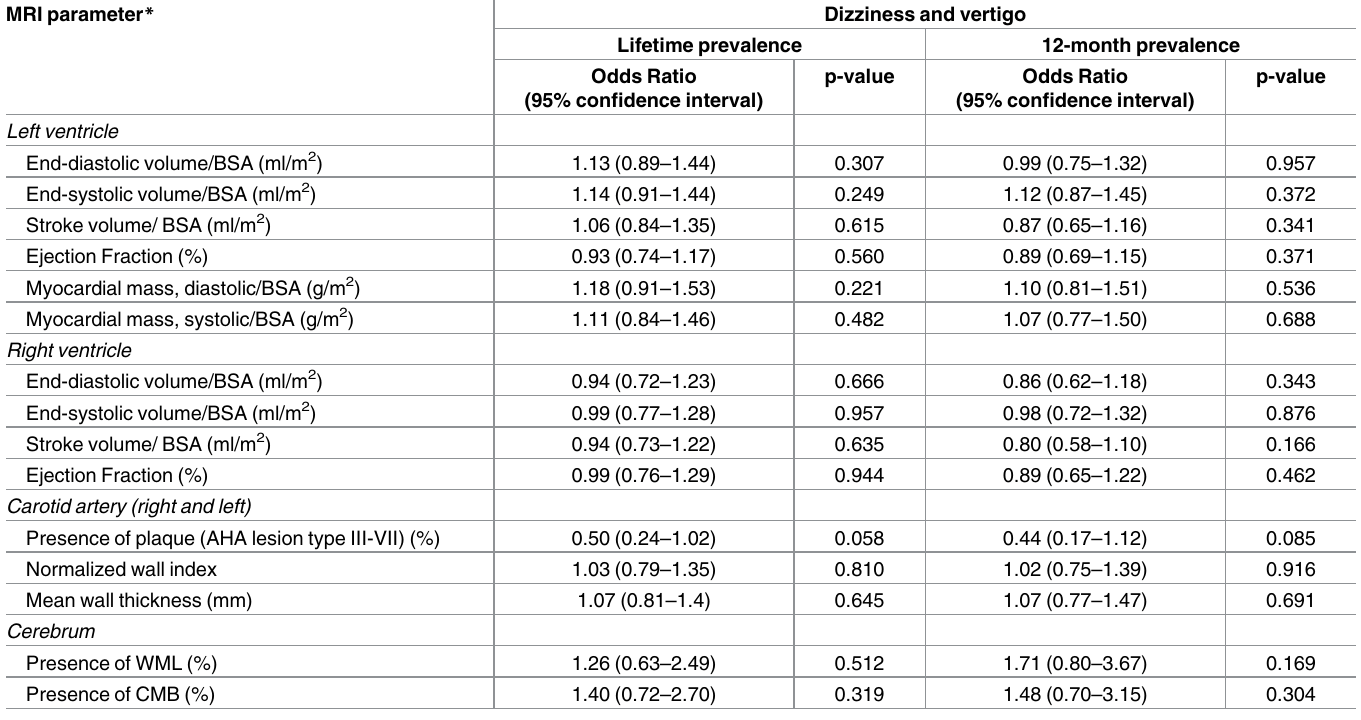
Table 3. Association of MRI determined cardiovascular measurements with dizziness and